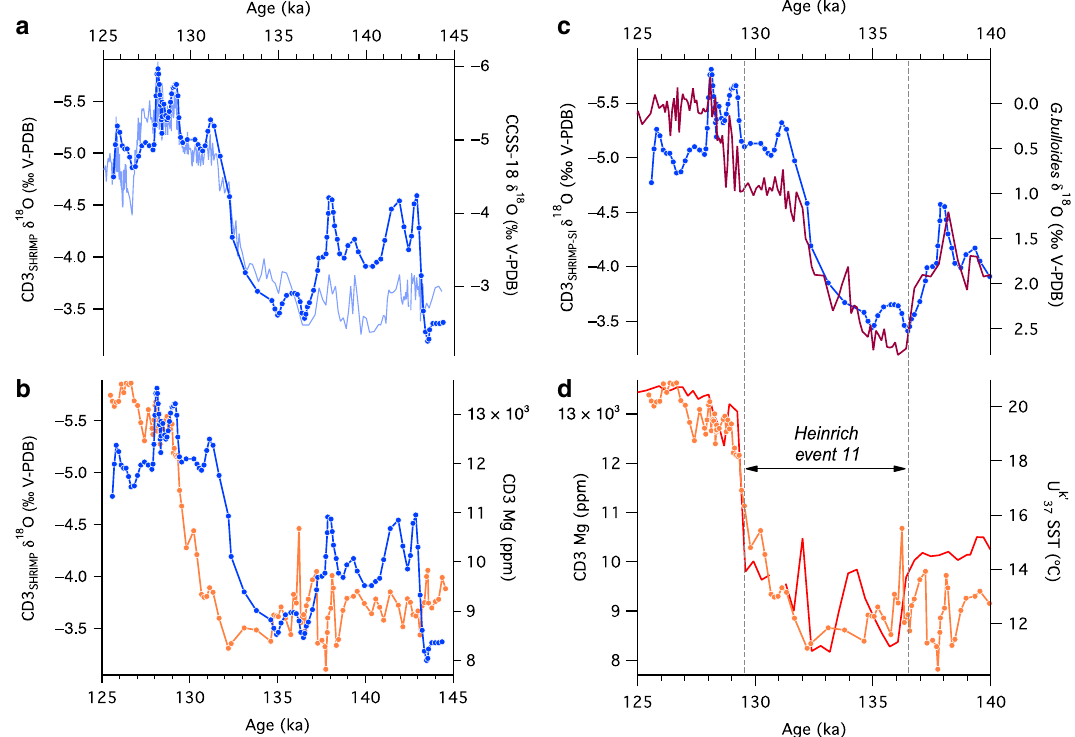
Fig. 5 CD3 and ocean-core data for Termination II. a SHRIMP-SI δ 18 O (dark blue with symbols) synchronized to the Corchia Cave speleothem δ 18 O stack 40 (CCSS-18: light blue) enabling the U-Th chronology from CCSS-18 to be transferred to the CD3-1 series. See ‘ Methods ’ and Supplementary Fig. 6. b SHRIMP-SI δ 18 O (blue) and laser-ablation (LA) ICP-MS Mg (orange) series plotted on the CCSS-18 chronology, highlighting the phasing of the large Mg increase and δ 18 O decrease across Termination II. c Comparison between the planktic δ 18 O ( G. bulloides ) (brown) from the Iberian margin and the high- resolution SHRIMP-SI δ 18 O from CD3-1 (blue with symbols). The ocean record is shown on the chronology of Tzedakis et al. 40 . d Comparison between the high-resolution LA-ICP-MS Mg CD3-1 data (orange with symbols) and Iberian-margin SST (red). The correlation between the Mg and SST series is statistically signi fi cant ( r = 0.92; p < 0.05; df = 36; see Supplementary Fig. 7). The grey panel marks the position of Heinrich Event